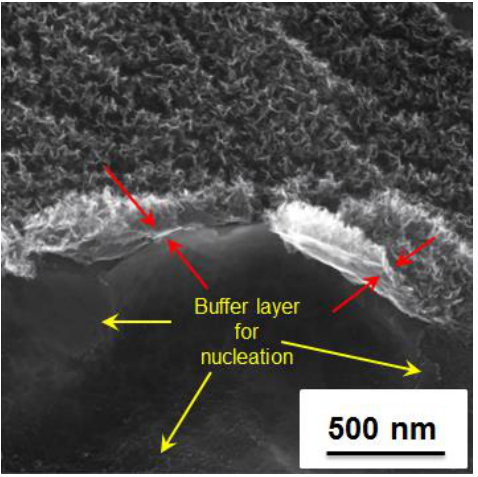
Figure A5. ( A ) Averaged Raman spectra of VOG coatings (Samples 1–5) measured at 473 nm excitation wavelength (100 × objective and 10 s of integration time). ( B ) Peak intensity values of G’, {D+G} and 2D’ Raman secondary order modes versus deposition time from 1 to 30 min (Samples 1–5).